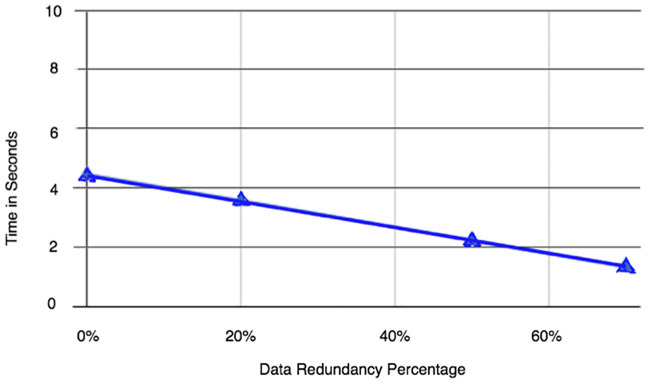
The required time of encryption vs. data redundancy percentage.